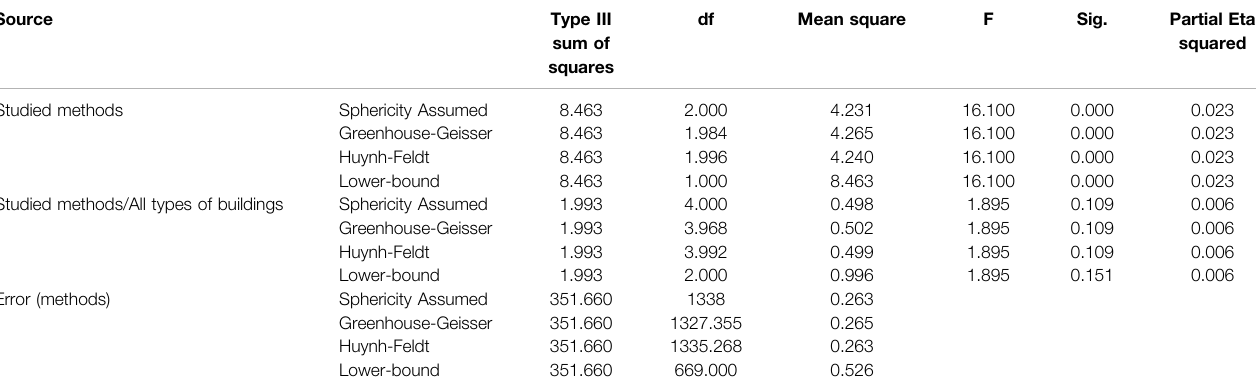
TABLE 7 | Tests of within-subjects effects. Source